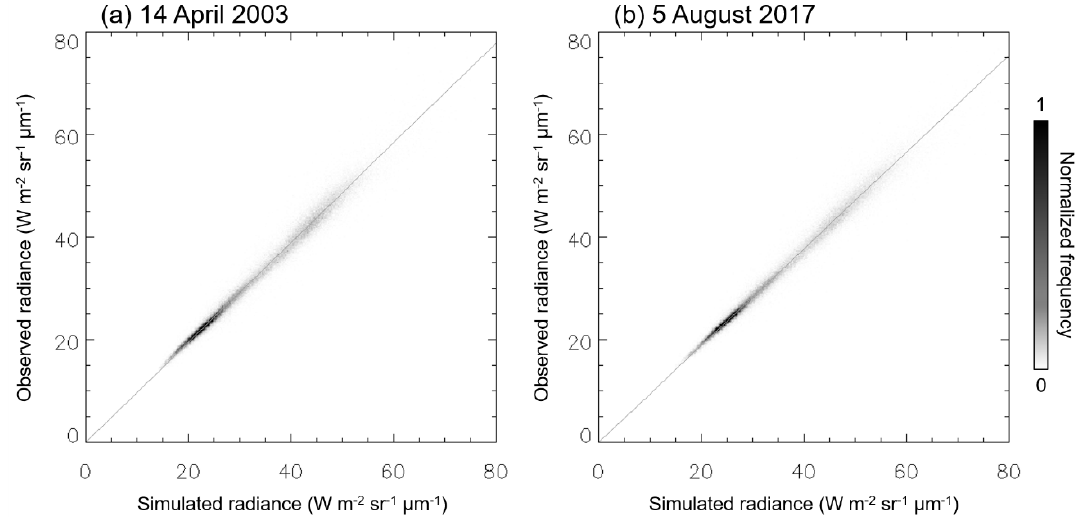
Figure 6. Comparison of simulated and observed radiance for Band 1 in ( a ) 2003 and ( b ) 2017. The simulated radiance was measured from the SP model. The gray scale represents the normalized frequency, and the gray line represents a line with a slope of the mean ratio between simulated and observed brightness in each plot.